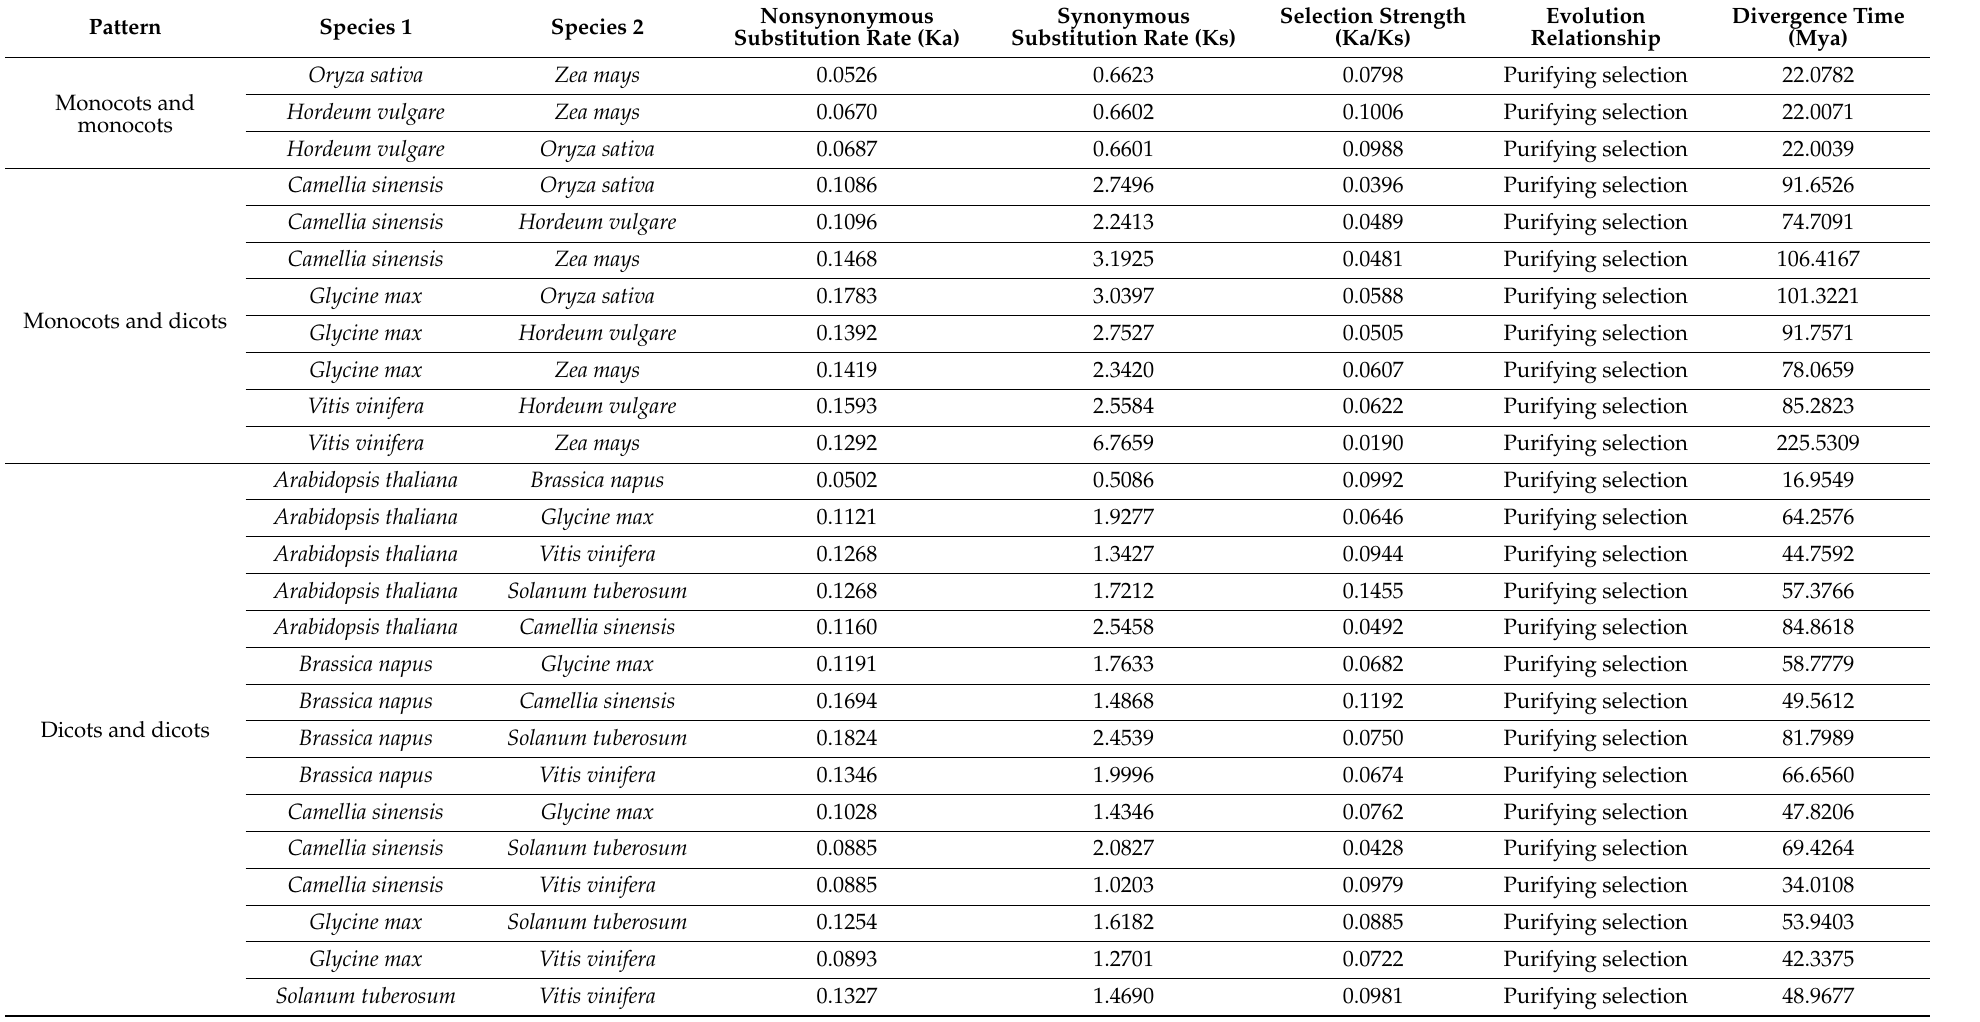
Table 1. Evolutional selection pressure between monocots and monocots, monocots and dicots and dicots and